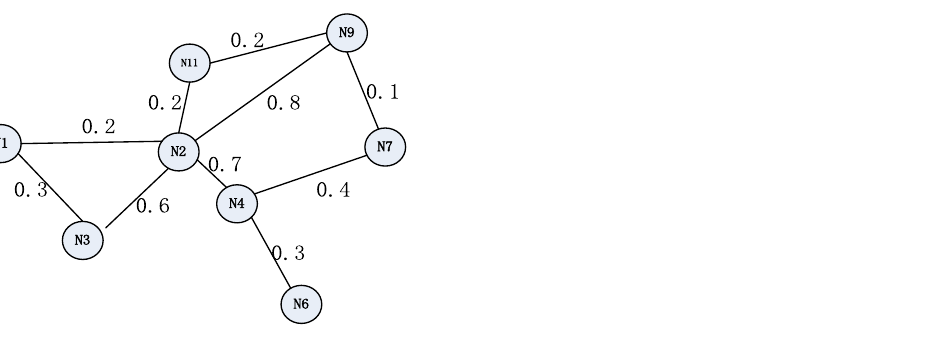
Figure 6. Undirected weighted contact